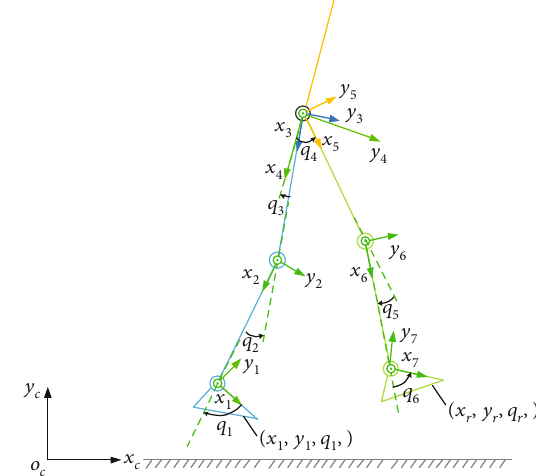
Figure 2: Coordinate frames for a fl oating exoskeleton (with positions of the exoskeleton feet changed). ð x Þ represent the positions of the left foot and right foot in the q r Cartesian coordinate frame,